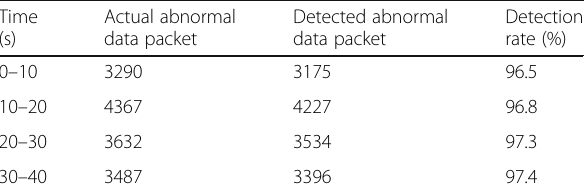
Table 2 Detection results of the proposed